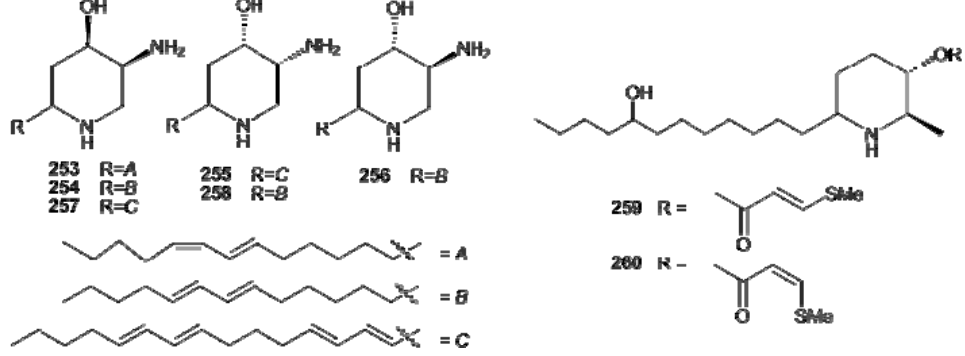
Figure 27. Structures of piperidine alkaloids pseudodistomins ( 253–258 ) and uoamines ( 259 , 260 ).